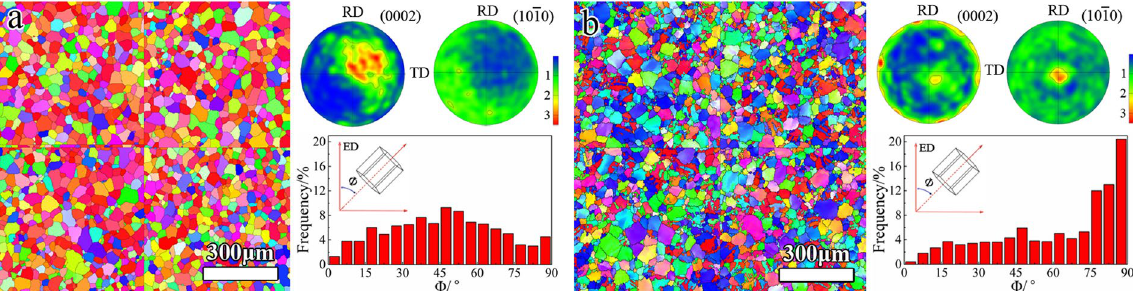
Figure 2. Inverse pole figure maps, pole figures and distributions of tilting angles of basal poles ( Φ ) with respect to the ED: ( a ) AS sample; ( b ) PT sample. Note that the RD and TD denote the radial direction and tangential direction, respectively.